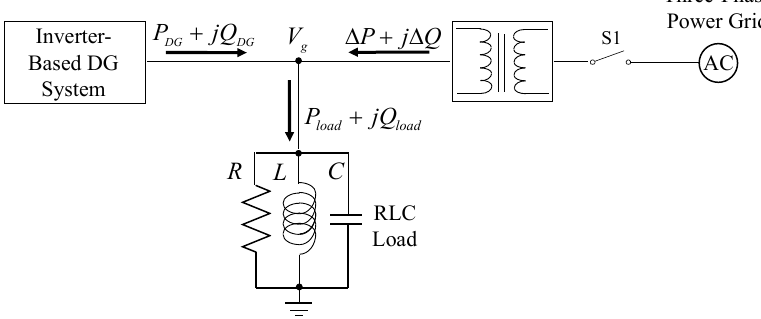
Figure 2. Power flowers of test circuit based on UL 1741.